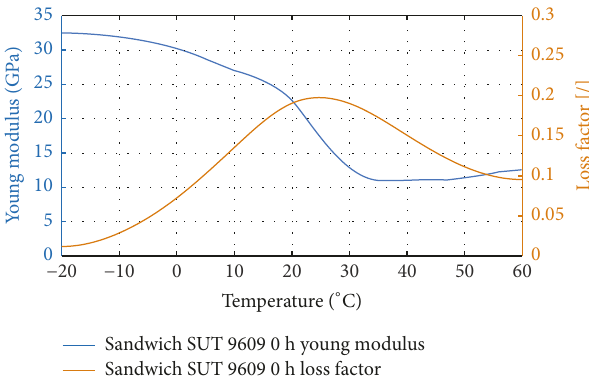
Figure3:Materialcharacteristicsasafunctionoftemperature:T300 + KRAIBON SUT9609/24